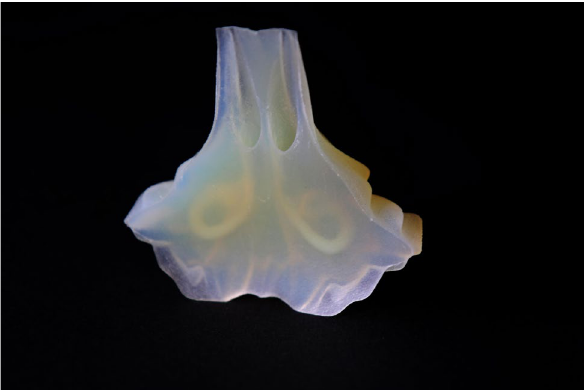
Figure 9 | Nose project Radiator / Resonator – photo of 3D printed object in Flexible material Tango Plus 9740. Technology polyjet, solidified liquid photopolymer by using UV light (back view).